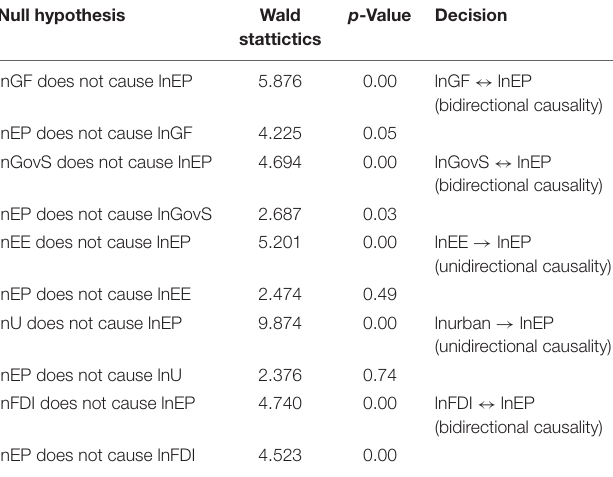
TABLE 7 | Causality test.